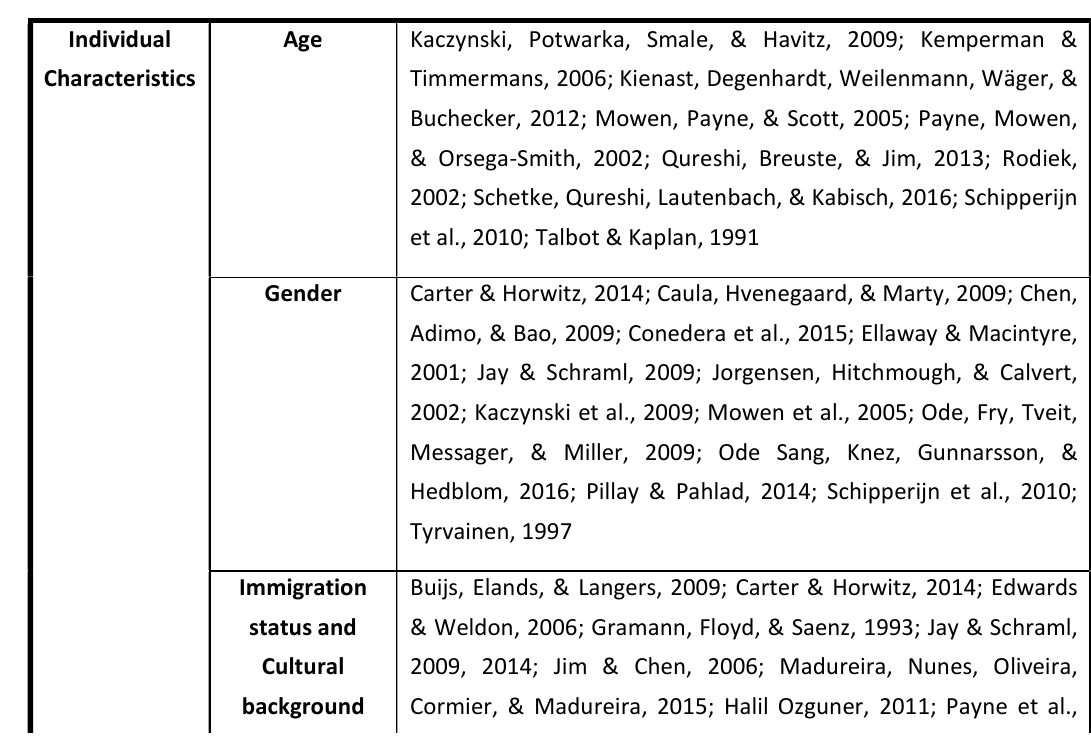
Table 2: Key references regarding the developed